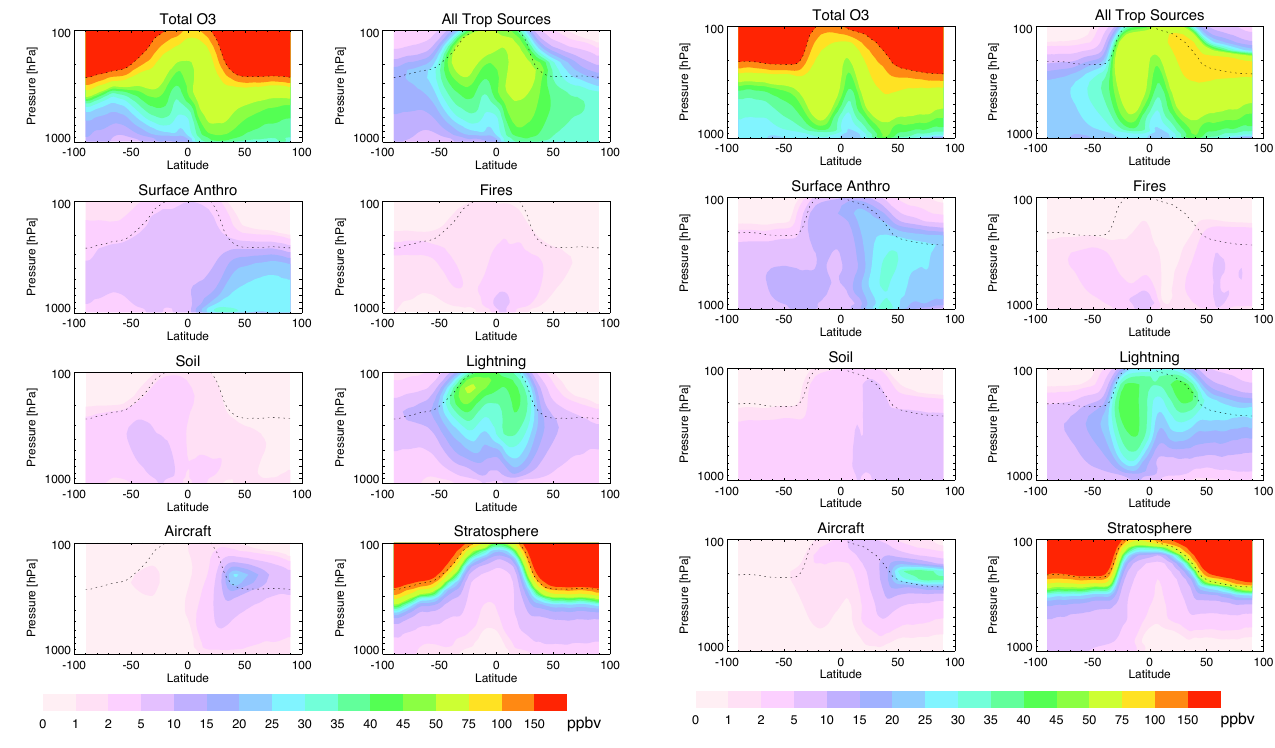
Fig. 4. Zonal average of each tagged ozone source for January 2008. Stratospheric contribution is determined as the difference between total ozone and tagged ozone from all tropospheric sources.